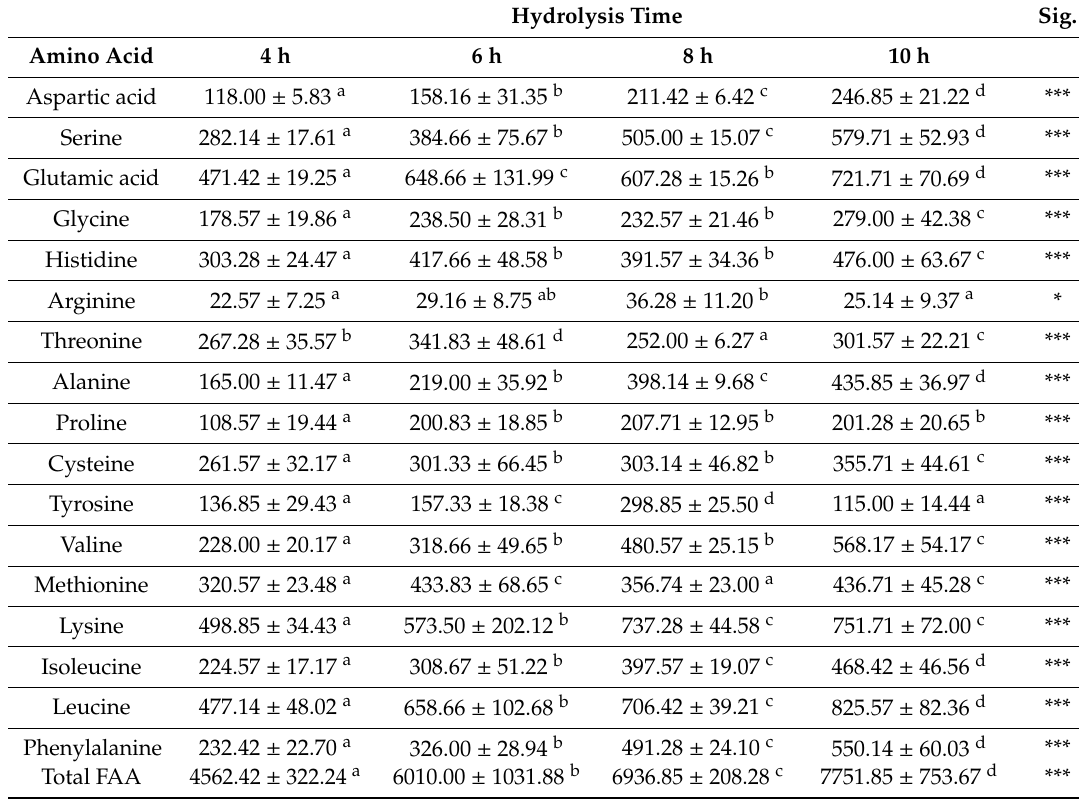
Table 1. E ff ect of hydrolysis time on free amino acid profile (mg / 100 g of pork liver) of porcine liver hydrolysates. Hydrolysis Time